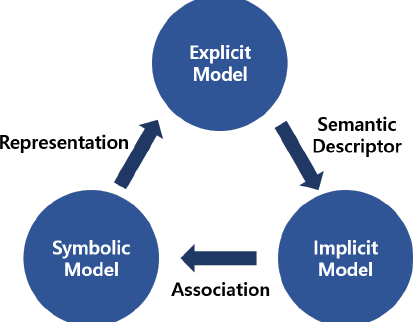
Figure 2. Triplet ontological semantic